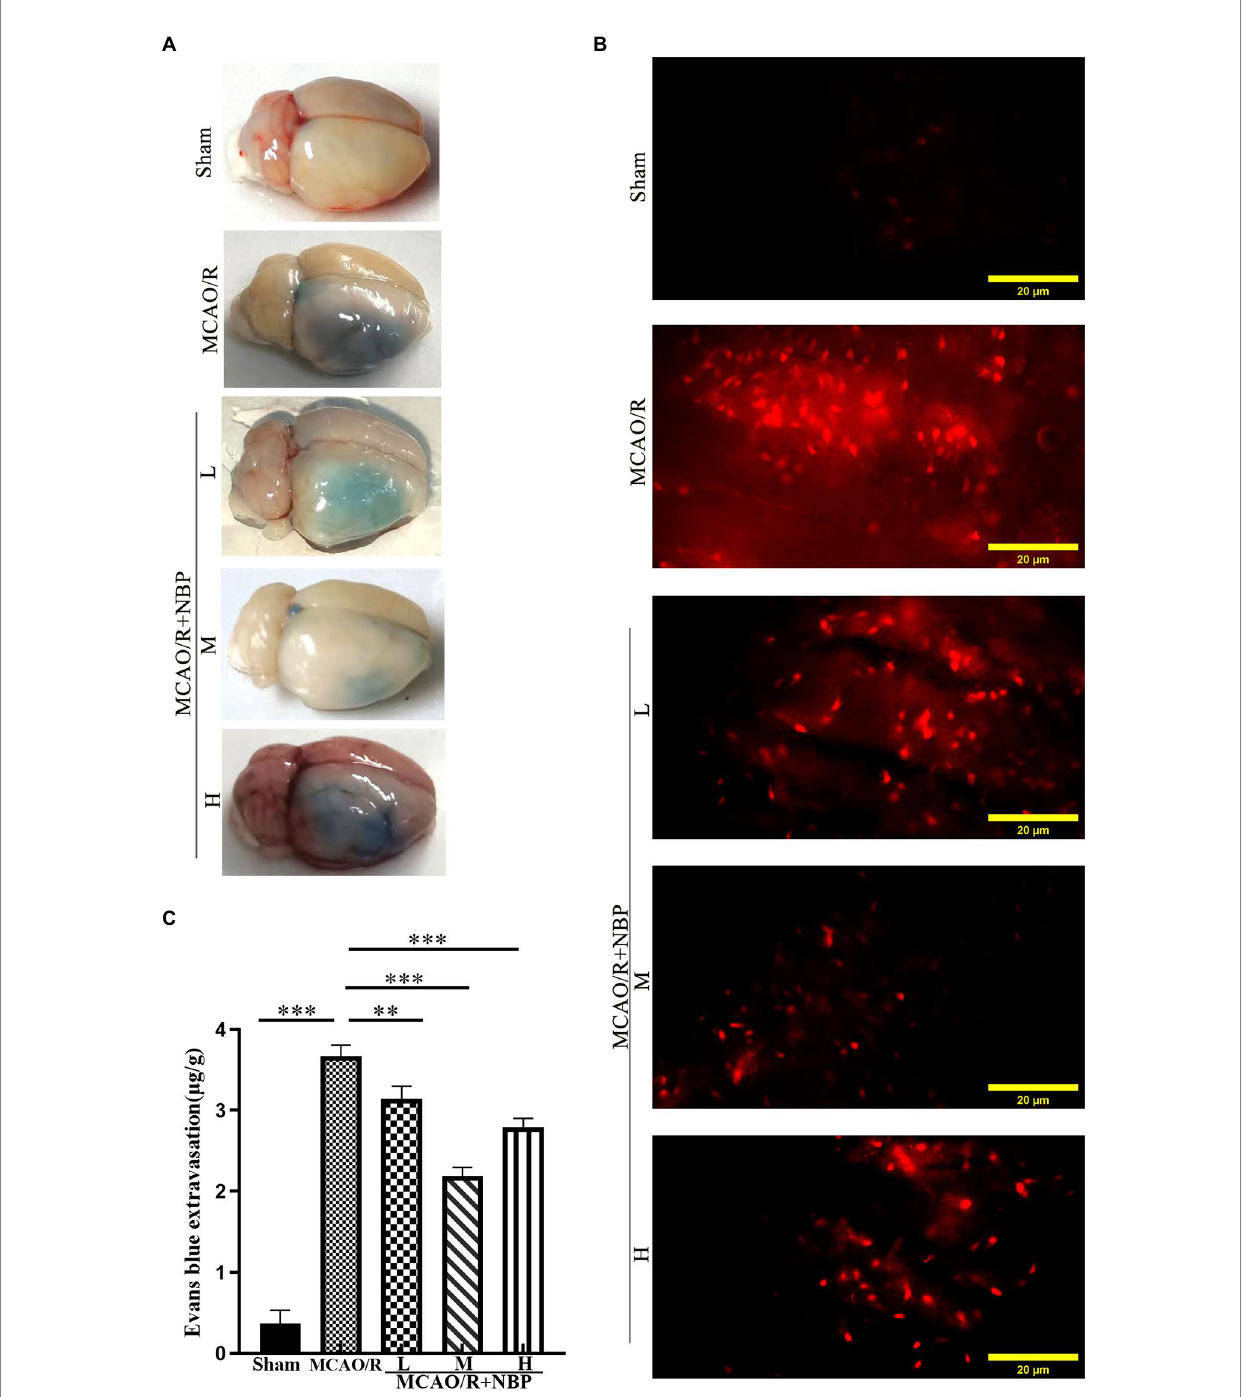
FIGURE 3 Evaluation of BBB Permeability. (A) The representative appearance of EB stained rats’ brains. (B) A fluorescence microscope observed the leakage of EB in rats’ frozen slices of brain tissue. (C) Quantitative analysis of EB content in brain tissue. EB, Evans blue; BBB, blood–brain barrier. * p < 0.05; ** p < 0.01; *** p < 0.001. The values represent the mean ± SD, n =